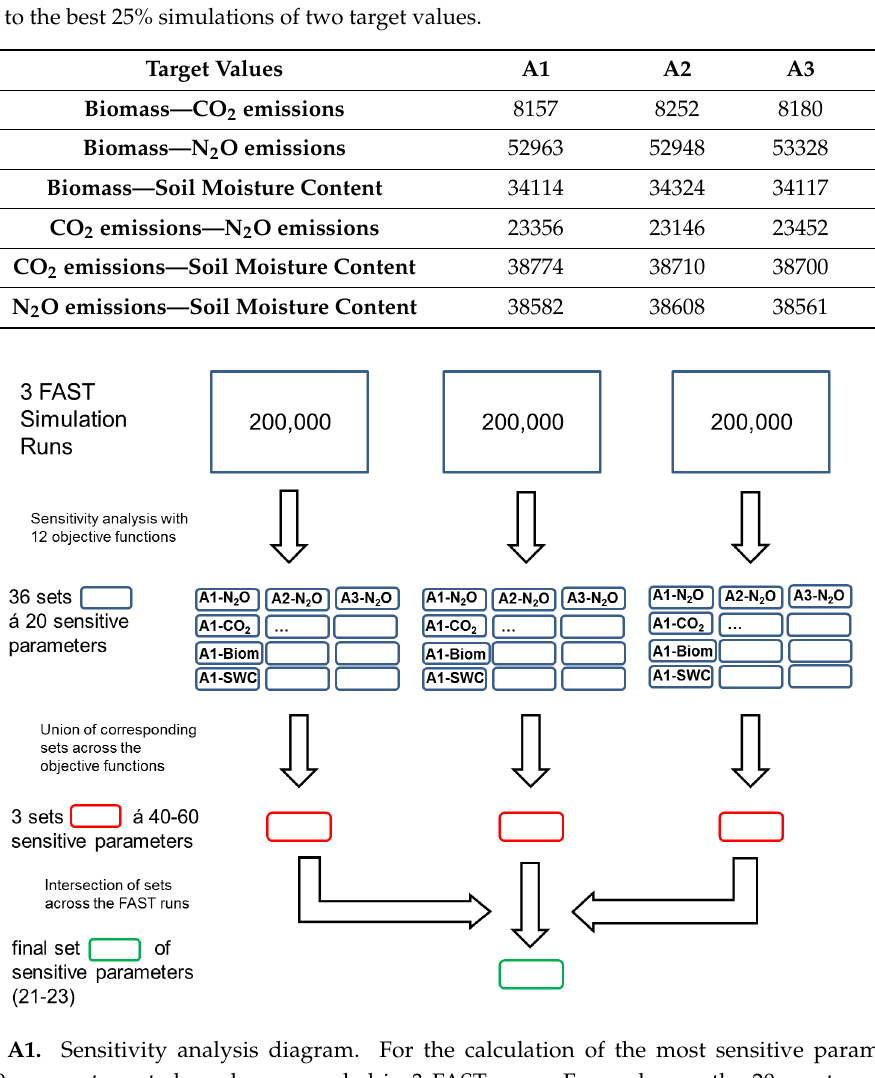
Figure A1. Sensitivity analysis diagram. For the calculation of the most sensitive parameters, 600,000 parameter sets have been sampled in 3 FAST runs. For each run, the 20 most sensitive parameters have been calculated separately for 12 objective functions (4 target values × 3 plots). After that, the sensitive parameters for each run have been unified. Finally, an intersection of the unified parameters was made among the FAST runs, creating the choice of sensitive parameters that was used for calibration.